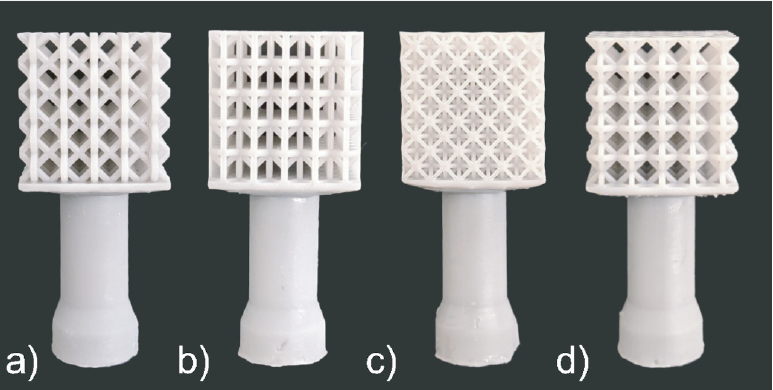
Figure 9. Set 2 printed patterns: ( a ) Proposed cell, ( b ) Hourglass, ( c ) Rhombic, and ( d ) Octet-Truss.